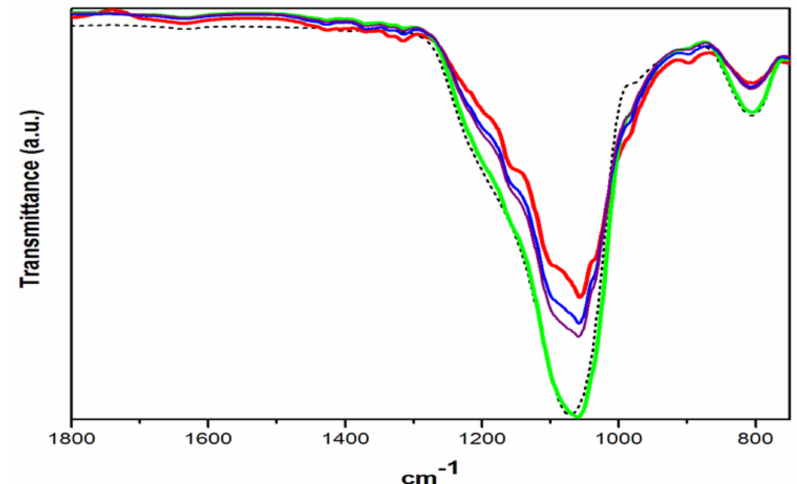
Figure 3. FTIR spectra of ASi (black dash line), CP19 (red line), CP20 (green line), CP21 (blue line) and CP22 (purple